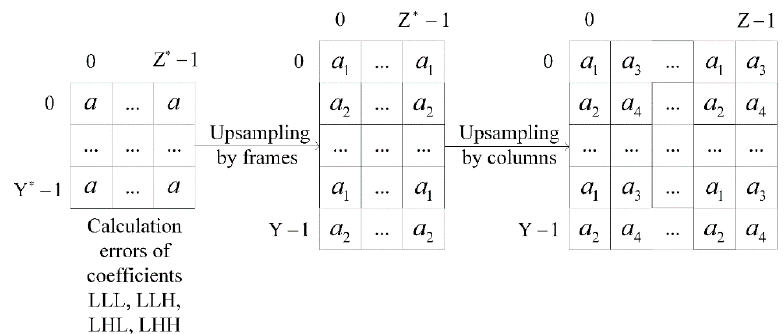
Figure 3. The scheme of the errors separation with upsampling by frames and columns.